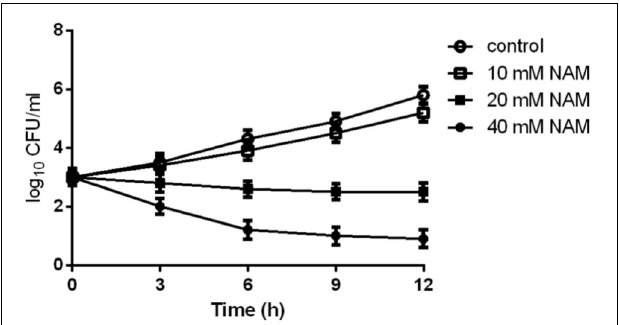
FIGURE 1 | Time-kill curves of NAM against C. albicans . Different concentrations of NAM were added to 1 × 10 3 cells/ml of C. albicans SC5314 cells suspended in RPMI 1640 medium. At each designated time points, portions of cell suspensions were withdrawn and plated on YPD agar to determine the CFU/ml of the cell suspensions. The data shown are means ± standard deviations from three independent experiments.